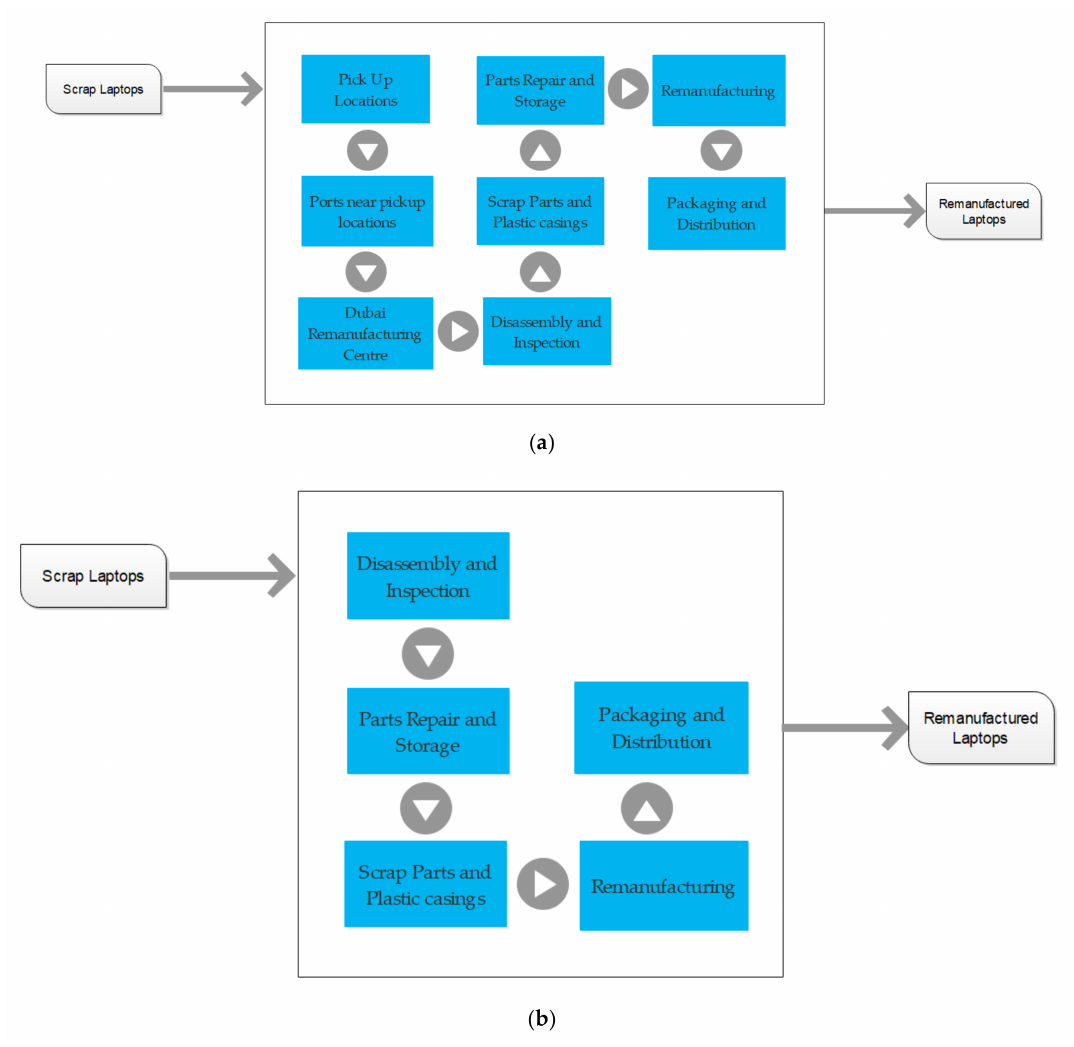
Figure 5. Boundary of ( a ) centralized remanufacturing; ( b ) decentralized remanufacturing.